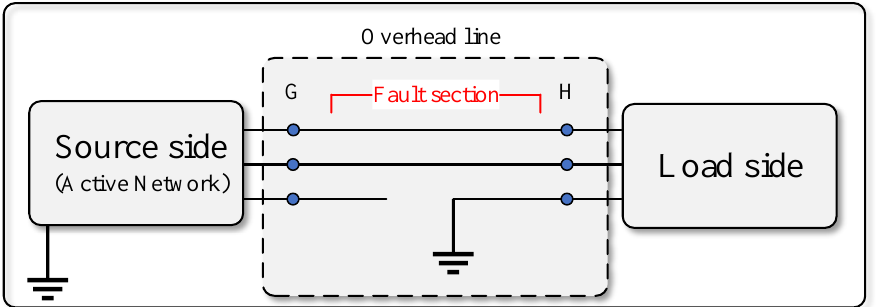
Figure 5. Description of a fault section.